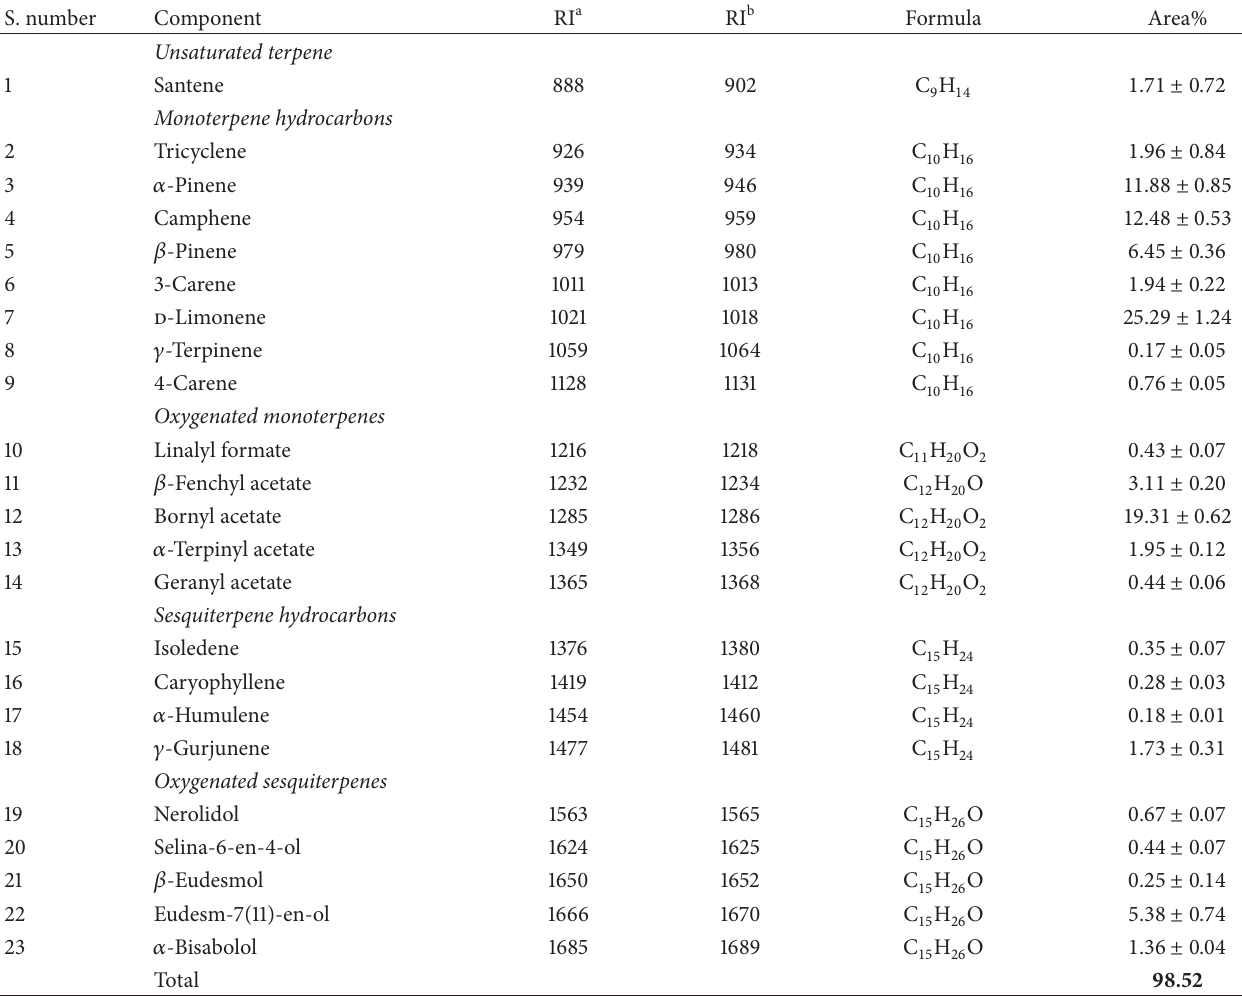
Table 2: Chemical composition of the essential oil from the twigs of A. koreana .